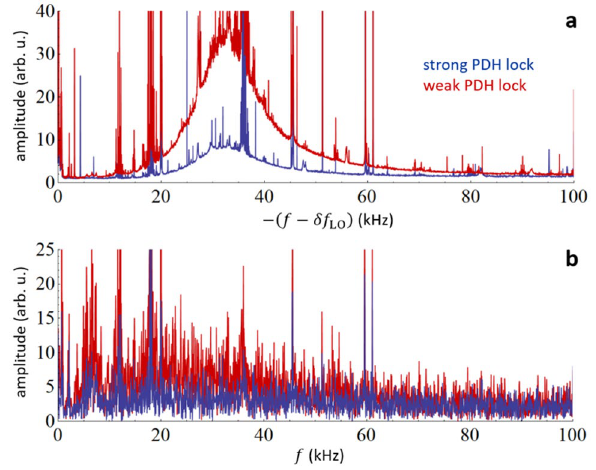
Figure 7. Dependence of cavity mode spectrum on the magnitude of comb-cavity phase noise. ( a ) Spectrum of a single cavity mode acquired under continuous excitation in the case of strong (blue) and weak (red) PDH lock of the CW laser to the ring-down cavity. The frequency axis is shifted by the beat frequency between the probe and LO comb tooth δ f LO = δω LO /( 2 π) , which excites the selected mode so that zero corresponds to the probe comb tooth center. This axis is also inverted to match the frequency axis of panel ( b ). ( b ) The spectrum of the PDH error signal in the case of a strong (blue) and weak (red) PDH lock, corresponding to the measured modes shown in panel ( a ).